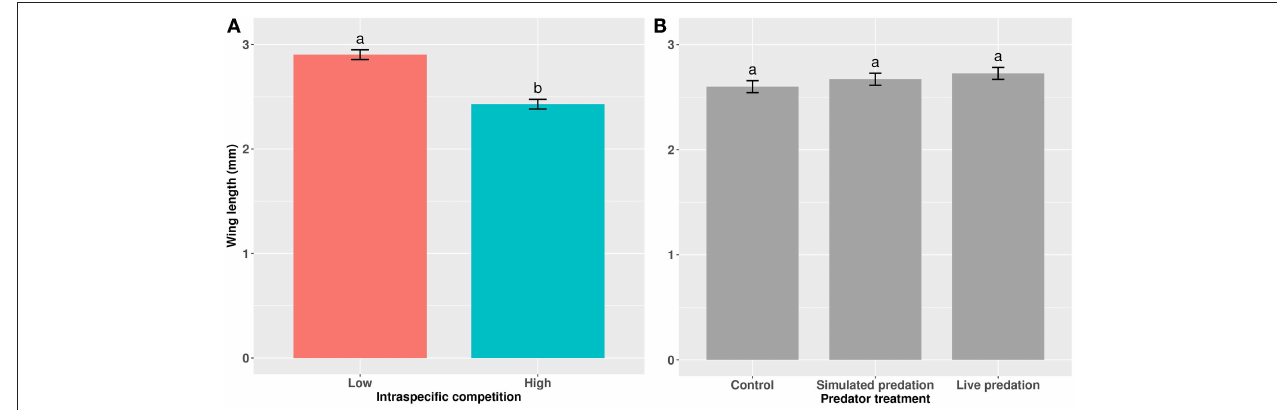
FIGURE 3 | Wing length of cohorts of female Aedes aegypti exposed to (A) intraspecific competition and (B) predator treatments as larvae. Values plotted are least squares means ± 95% CI. Data were statistically tested using ANOVA and significant effects are described in Table 3 . Treatment means within (A) and within (B) associated with the same letters are not significantly different in pairwise comparisons using Bonferroni adjustment for multiple tests.